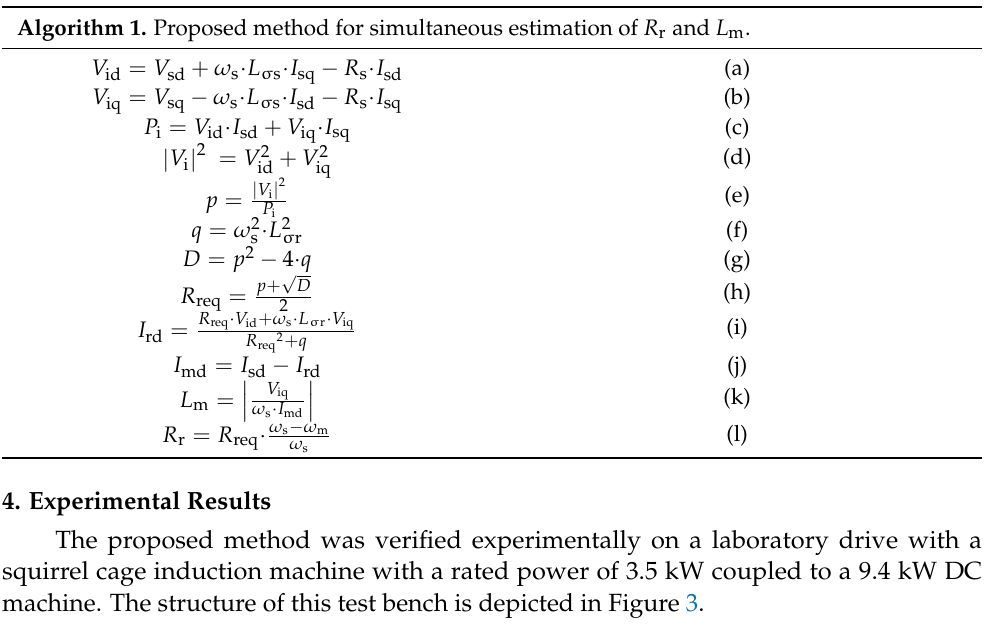
Table 1. Tested machine rated parameters (type 1AY112L-6, producer: EM Brno Ltd.). Rated Values